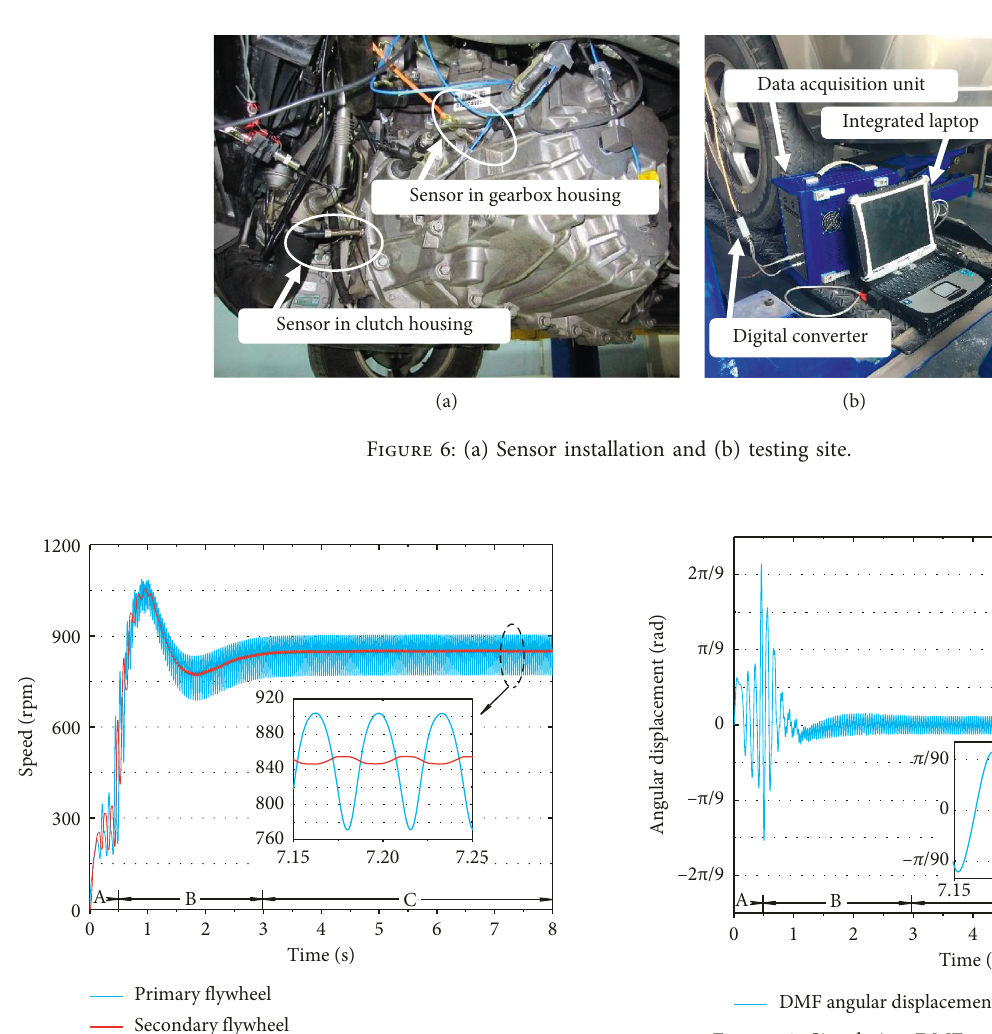
Figure 9: Simulating DMF angle